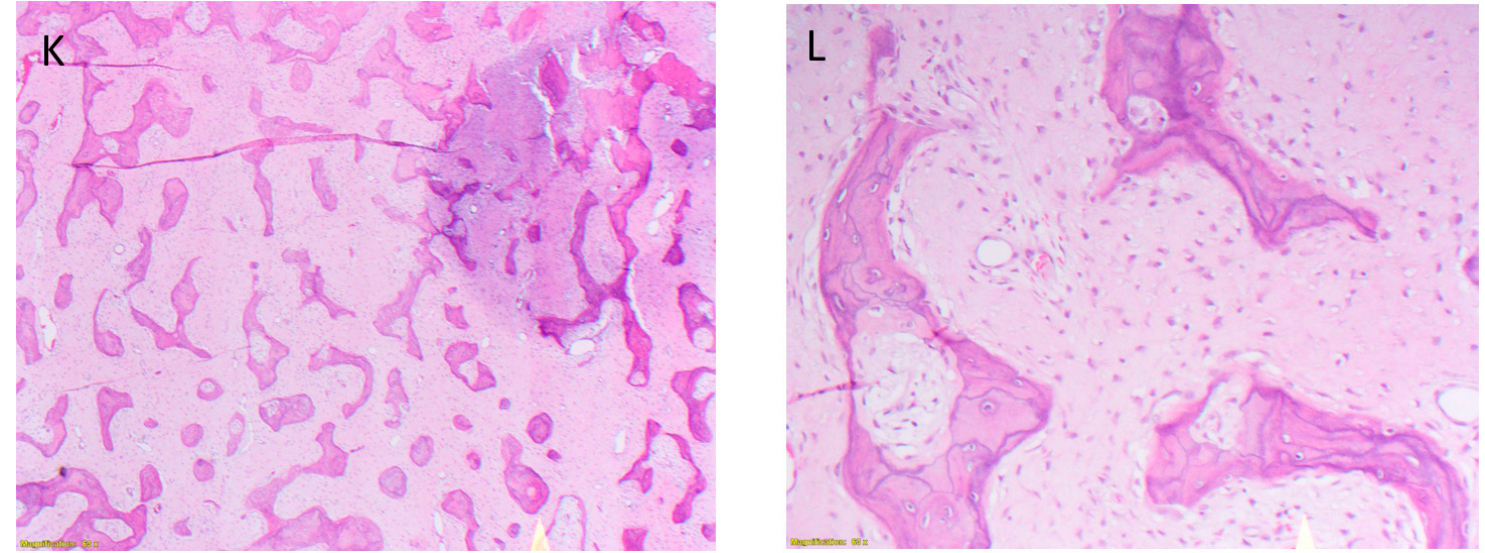
Figure 1. ( A ) 26-year-old man presented with a right-sided skull mass that had steadily increased in size since he first noticed it 5 years ago. After a 2–3-fold increase in the rate of growth over the prior year, he began to complain of bi-temporal headaches. ( A ) Ultrasound imaging revealed a 2.3 cm subcutaneous anechoic lesion with strong posterior acoustic shadowing and without vascularity. ( B – D ) Axial CT slice, 3D volume rendered CT and coronal CT slice revealed an exophytic lesion with ground-glass matrix on the surface of the outer table of the right coronal suture. ( E ) 99m Tc-MDP whole body bone scan revealed intense focal uptake on the right side of the skull. ( F ) Coronal reconstruction of bone scan SPECT images localized the focal uptake anteriorly on the right. ( G ) Coronal SPECT/CT images co-localized the intense focal uptake to the exophytic lesion on CT. ( H – I ) Representative sagittal FLAIR sequence and axial T1-weighted image revealed a T1 and T2 hypointense exophytic lesion arising from the outer table of the right coronal suture without bone marrow edema. ( J ) Sagittal 3D contrast-enhanced MRI revealed intense homogenous enhancement in the lesion without surrounding invasion. The overall differential diagnosis was broad, favoring benign osseous lesions such as osteochondroma, enchondroma protuberans, and surface osteoma, over less likely malignant lesions such as parosteal osteosarcoma [1] . Given the recent increase in the rate of growth, headache and large size, the lesion was excised via craniotomy followed by cranioplasty. ( K ) is a low-power image showing thin, irregular, curvilinear trabeculae of woven bone, whereas ( L ) is a high-power image showing bland fibroblastic cells and a lack of conspicuous osteoblastic rimming, consistent with fibrous dysplasia (FD). FD is a typically benign osseous lesion, constituting 5% of all benign bone lesions [2] . It is a non-inherited anomaly typically presenting before 30 years of age and involving the craniofacial bones, femur, tibia, ribs and pelvis [2] . In FD, normal bone marrow is replaced by fibro-osseous tissue; therefore, it is typically intramedullary [3] . The exophytic subtype of FD or FD protuberance is an extremely rare variant of FD, with only two case reports in the literature, first described in 1994 [4,5] . This rare variant mimics benign lesions such as osteochondroma, exostosis, surface osteoma, enchondroma protuberance, and even malignant bone tumors such as osteosarcoma and chondrosarcoma. To our knowledge, the FD protuberans variant is not described in the nuclear medicine or radiology literature [4–6] . As such, this case report appears to be the first imaging evaluation of FD protuberans [7,8] .